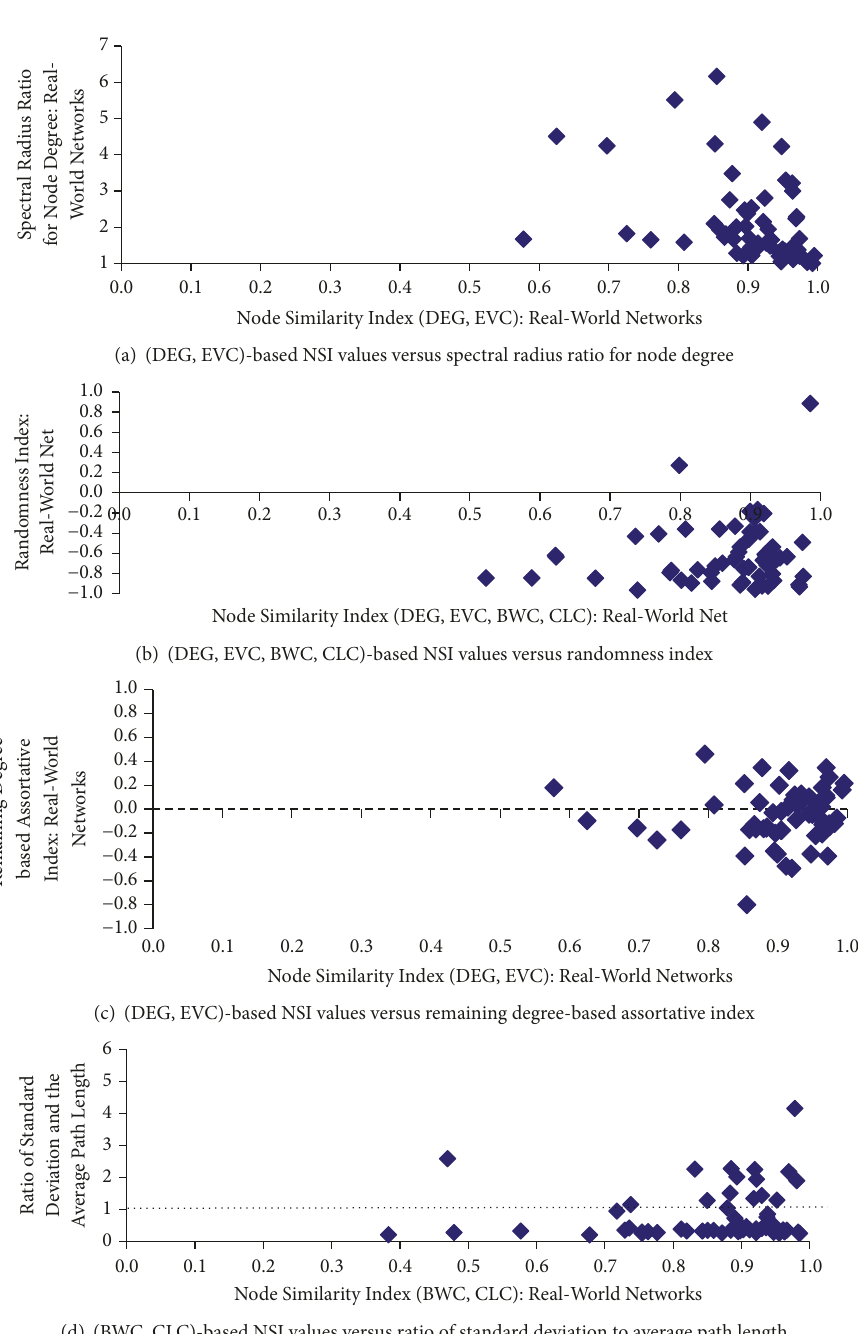
Figure 8: Comparison of the centrality-based node similarity index values for the real-world networks with some of the related network-level